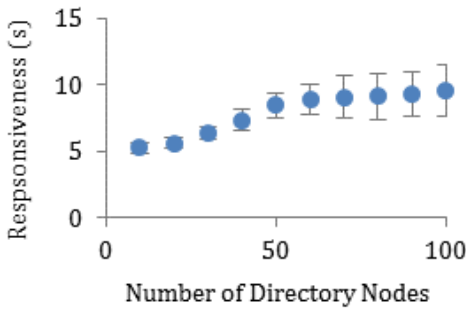
Figure 11. System responsiveness with the number of directory nodes.